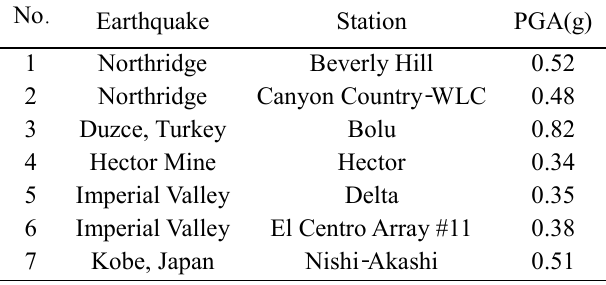
Far-Field Earthquakes Applied to the